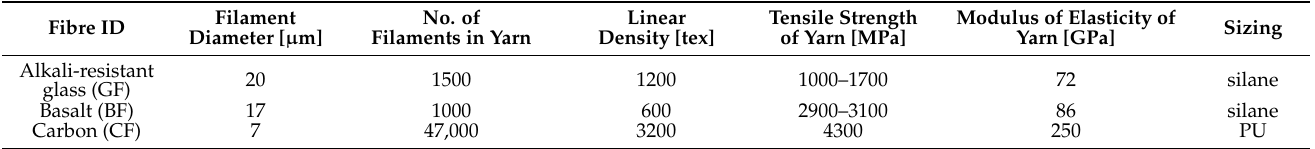
Table 1. Characteristics of waste fibres as obtained by the manufacturer.